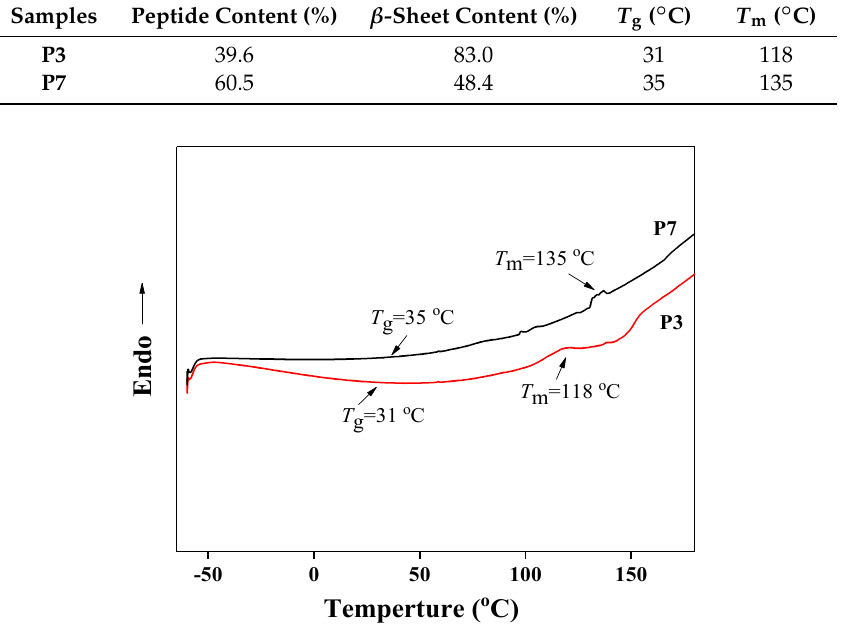
Figure 3. Differential scanning calorimetry (DSC) curves of P3 and P7 .